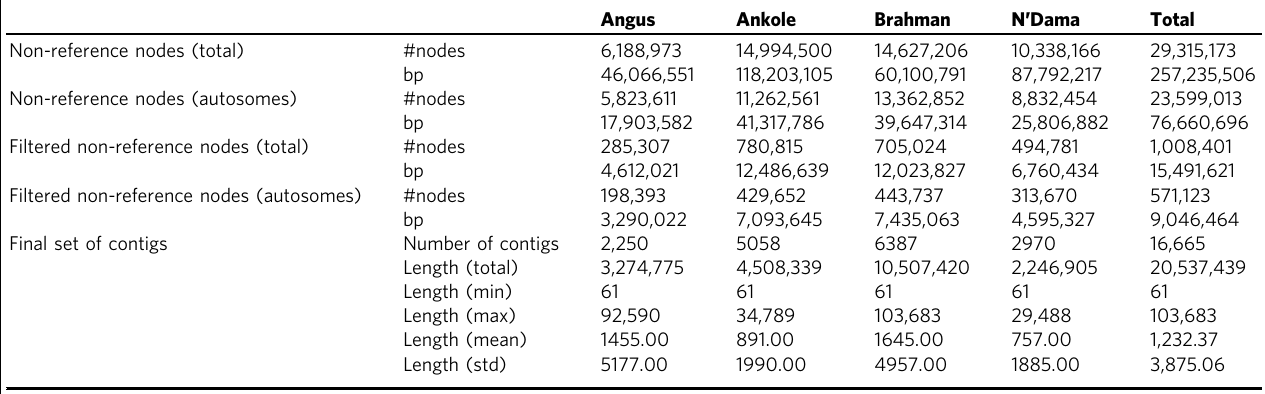
Table 1 Sequence contribution from the two African